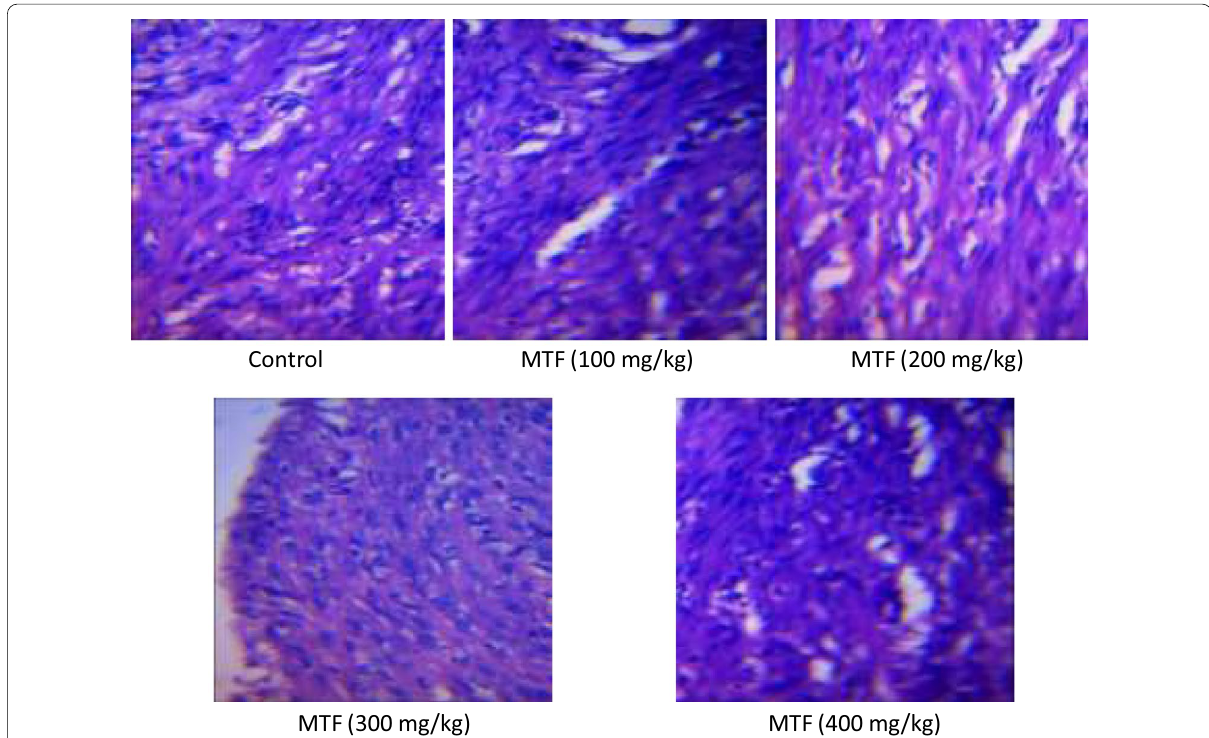
Fig. 5 Histological study on the effect of oral administration of metformin on the rat uterine sections using H&E staining (Mag. X 400). Control: The cellular architecture of myometrium was normal. MTF (100 mg/kg): There was no significant lesion. MTF (200 mg/kg): There was no significant lesion. MTF (300 mg/kg): There was no visible lesion. MTF (400 mg/kg): There was no visible